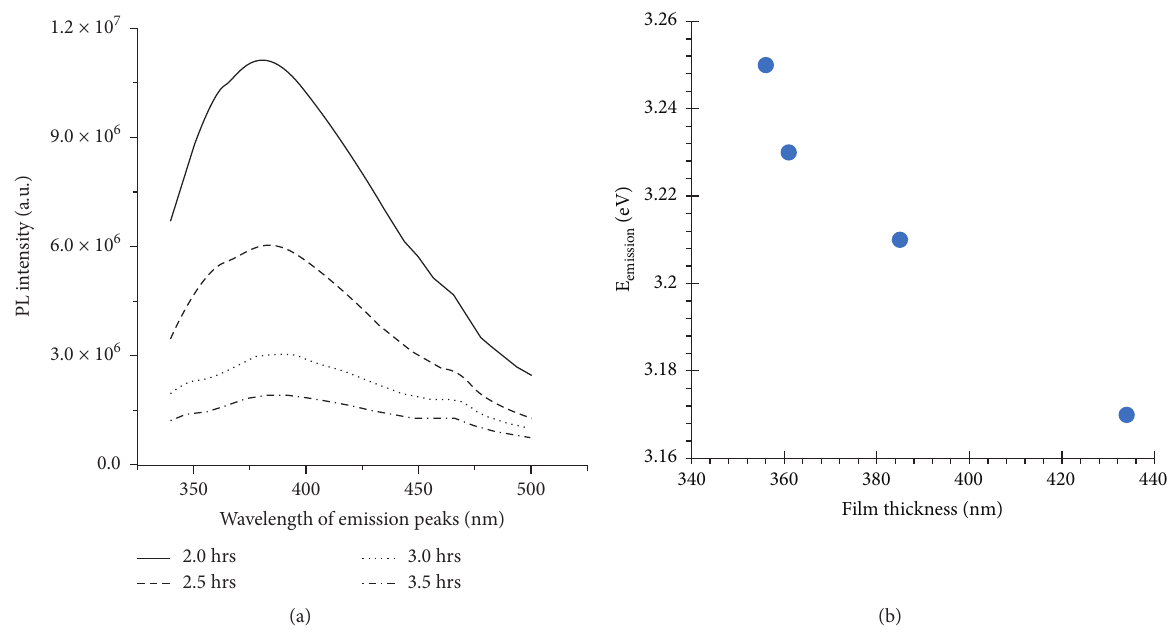
Figure 6: (a) The photoluminescence spectra and (b) the emission energy of intense PL peak (E thin films deposited at various deposition